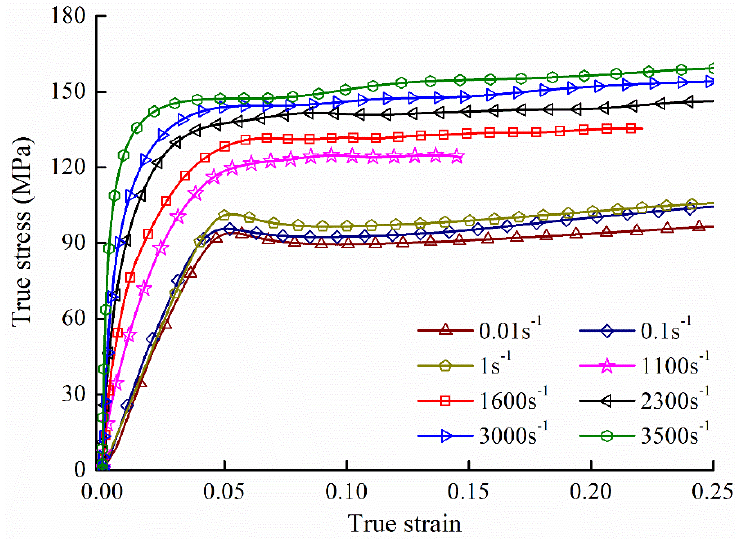
Figure 3. Low and high strain-rate results of PA66.